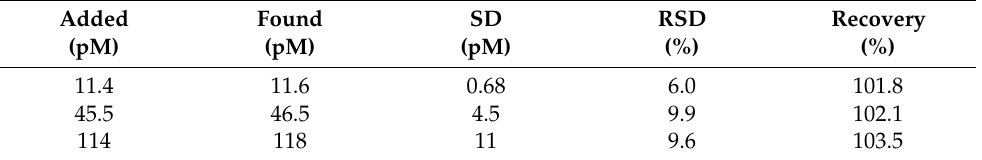
Table 1. Precision and recovery of HE4 with the developed biosensor (n = 24).